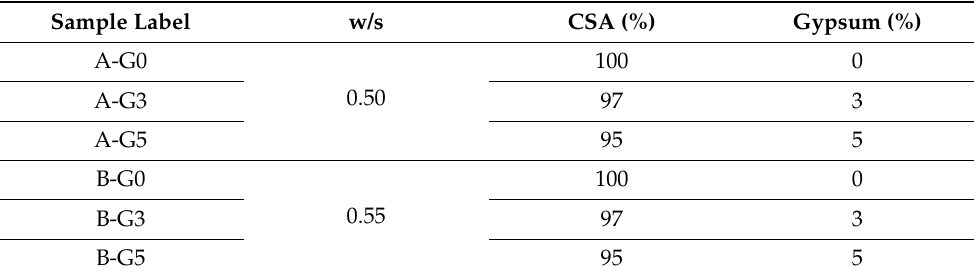
Table 4. Mixture proportions of paste samples.